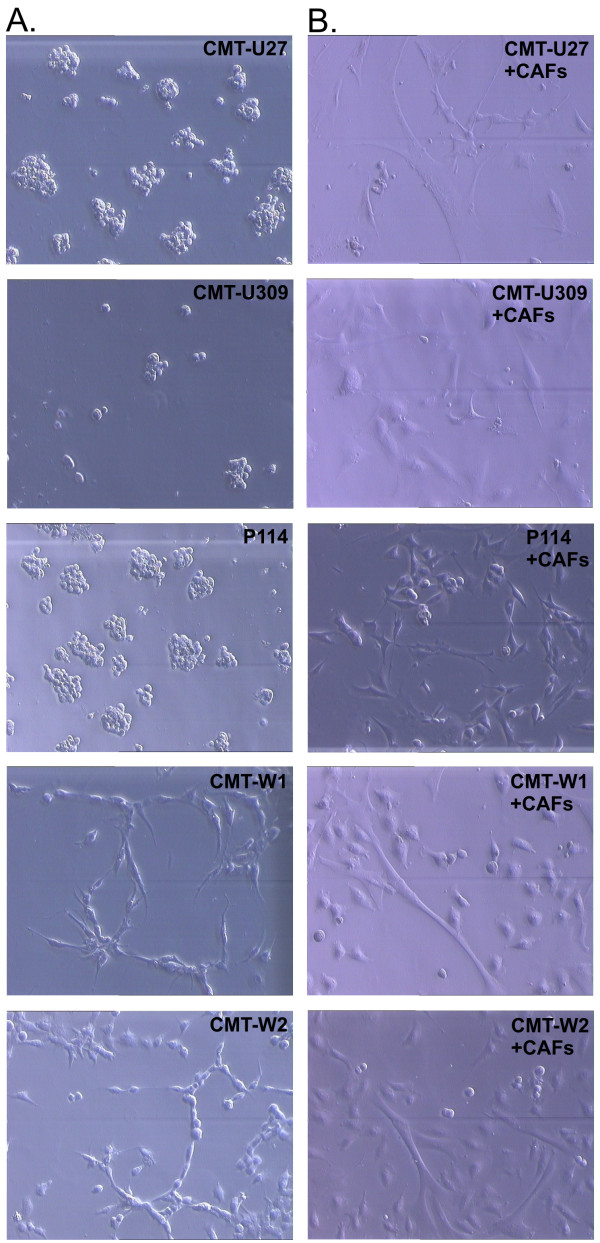
Canine mammary cancer cell lines growth characteristics in Matrigel matrix. A Growth characteristics of CMT-U27, CMT-U309, P114, CMT-W1 and CMT-W2 cell lines (phase contrast micrographs) grown on Matrigel matrix for 72 hours. B Growth characteristics of CMT-U27, CMT-U309, P114, CMT-W1 and CMT-W2 cell lines (phase contrast micrographs) grown as a co-culture with CAFs on Matrigel matrix for 72 hours. The pictures were taken using phase-contrast microscopy (Olympus) at the magnification of 200×.